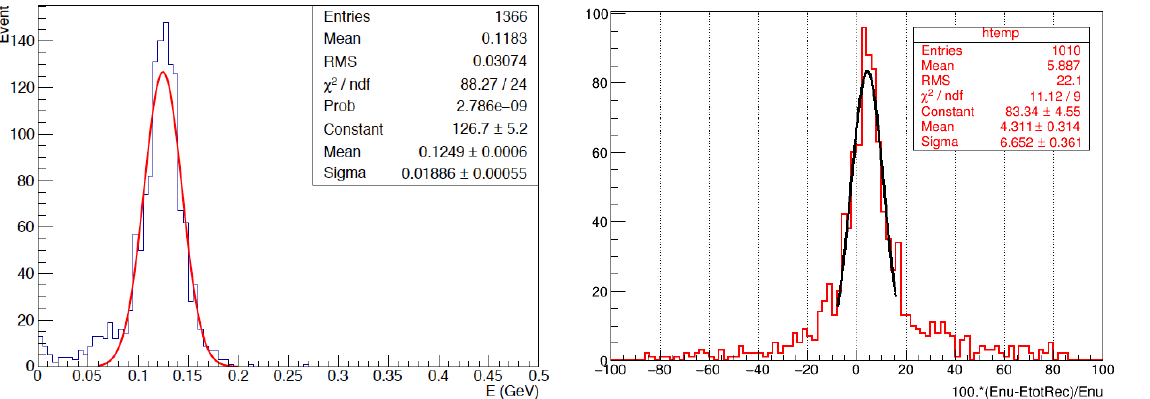
Figure 121. ( Left ): π 0 ’s invariant mass computed using the ECAL information for ν µ CC interactions with one π 0 . ( Right ): Reconstructed neutrino energy in ν µ CC events using ECAL